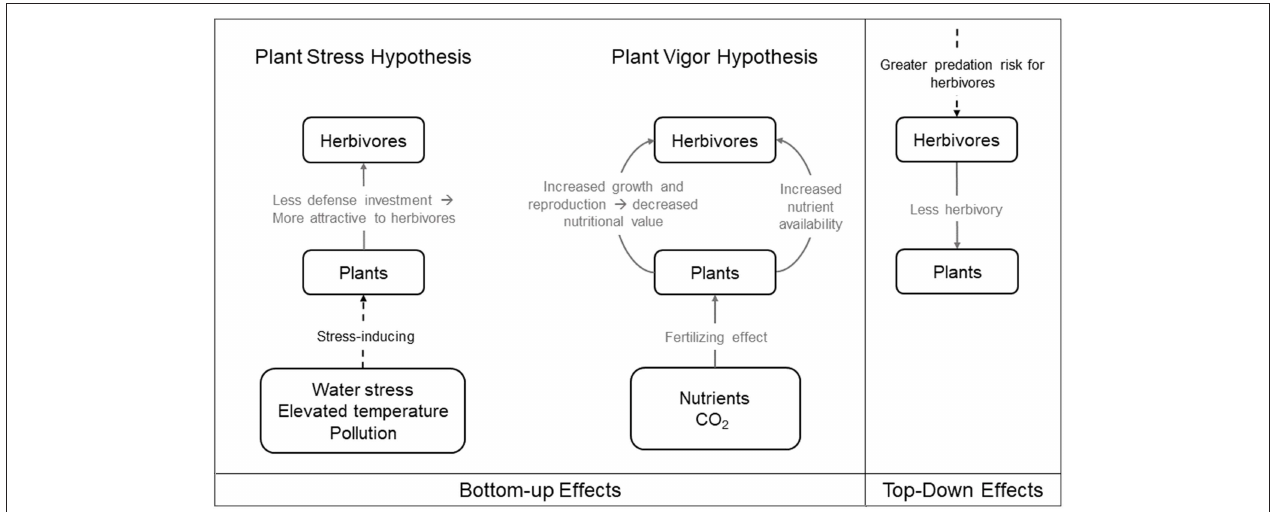
FIGURE 2 | Bottom-up and top-down effects in urban environments. Solid gray line indicates process that benefits recipient, dashed black line indicates process that harms recipient. The left panel illustrates the bottom-up effects on herbivorous arthropods under the two competing hypotheses: the Plant Stress Hypothesis, where plants subject to stress may decrease investment in defenses and thus experience greater herbivore damage, and the Plant Vigor Hypothesis, where plants with more growth are more attractive to herbivores and consequently suffer from greater herbivore attack. The right panel illustrates the top-down effects on herbivorous arthropods.